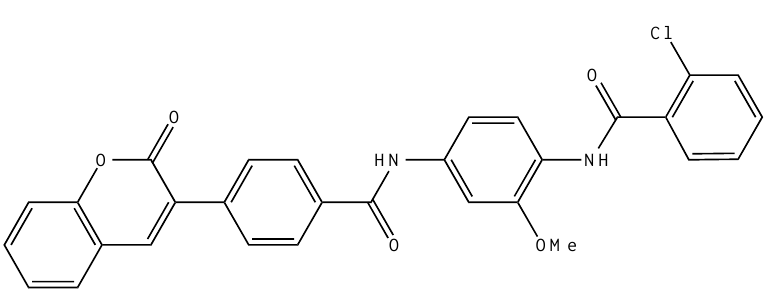
Figure 5. Structure of DosR inhibitor